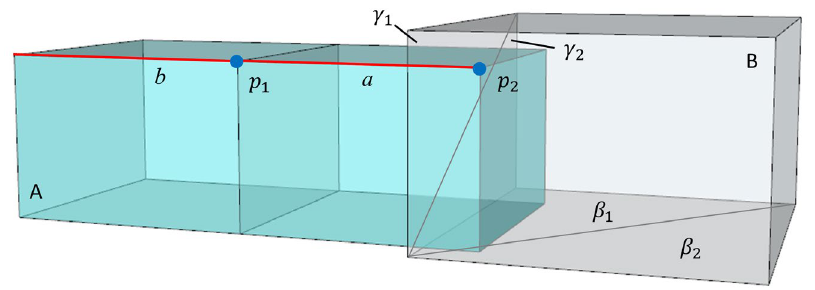
and are the boundary and ordinary edges, respec- Figure 8. Extraction of boundary vertices ( Figure 8. Extraction of boundary vertices ( a and b are the boundary and ordinary edges, respectively; tively; and are the ordinary vertex and boundary vertex, respectively; in component p 1 and p 2 are the ordinary vertex and boundary vertex, respectively; in component B , only the 𝑎𝑎 𝑏𝑏 only the triangles and intersect with the bounding box of component and participate in triangles γ 1 and γ 2 intersect with the bounding box of component A and participate in the next 𝑝𝑝 1 𝑝𝑝 2 the next intersection detection). intersection 𝛾𝛾 1 𝛾𝛾 2